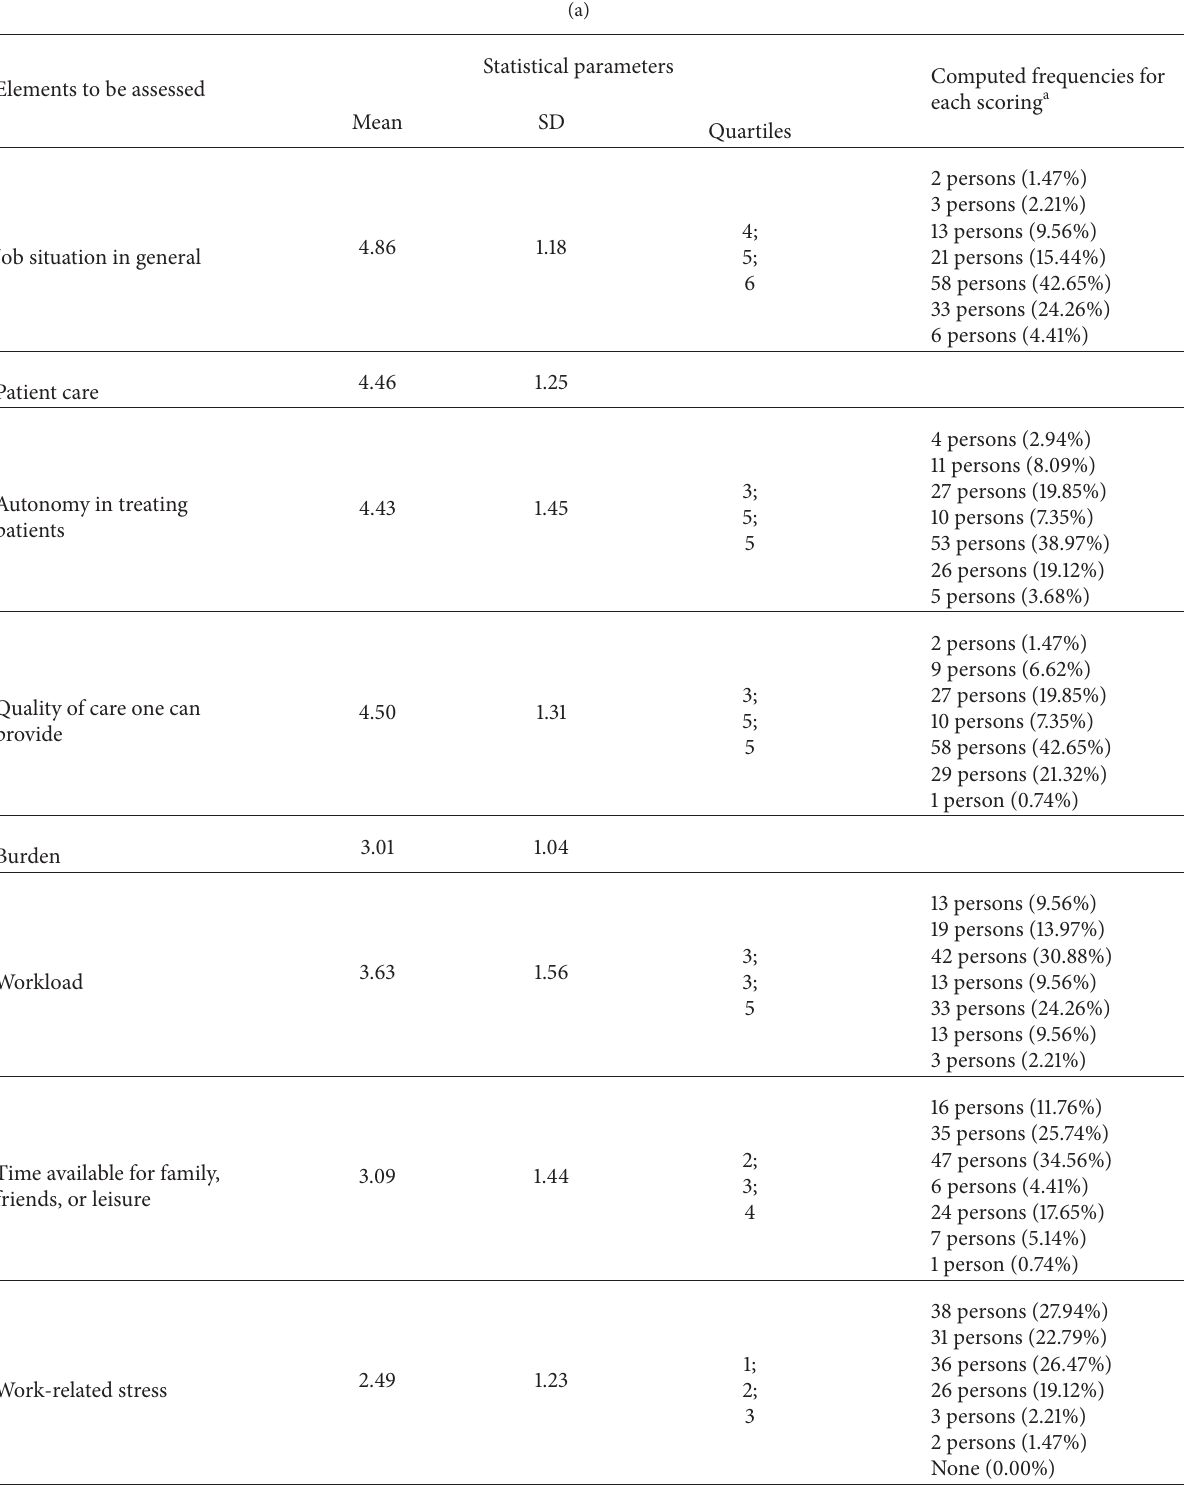
Table 2: (a) Computed statistical parameters (mean, SD, and quartiles) along with frequencies for job situation in general and patient care aspects among surveyed anesthesiologists. (b) Computed statistical parameters (mean, SD, and quartiles) along with frequencies for each scoring referring to income-prestige among surveyed